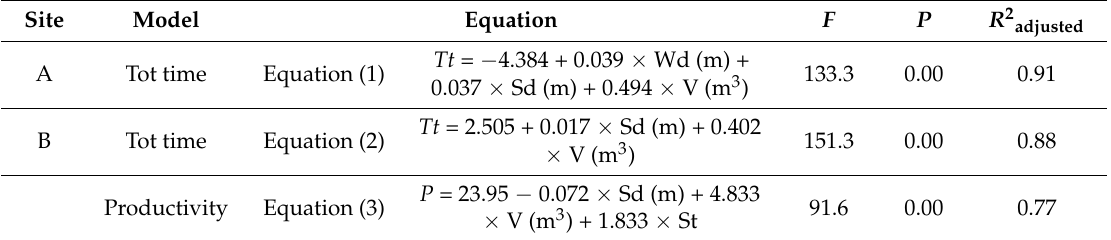
Table 6. Cycle time and productivity equations for sites A (cable skidder) and B (grapple skidder). Site